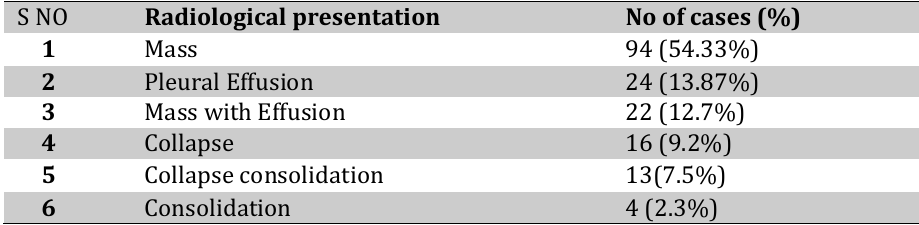
Table 3. Imaging Findings